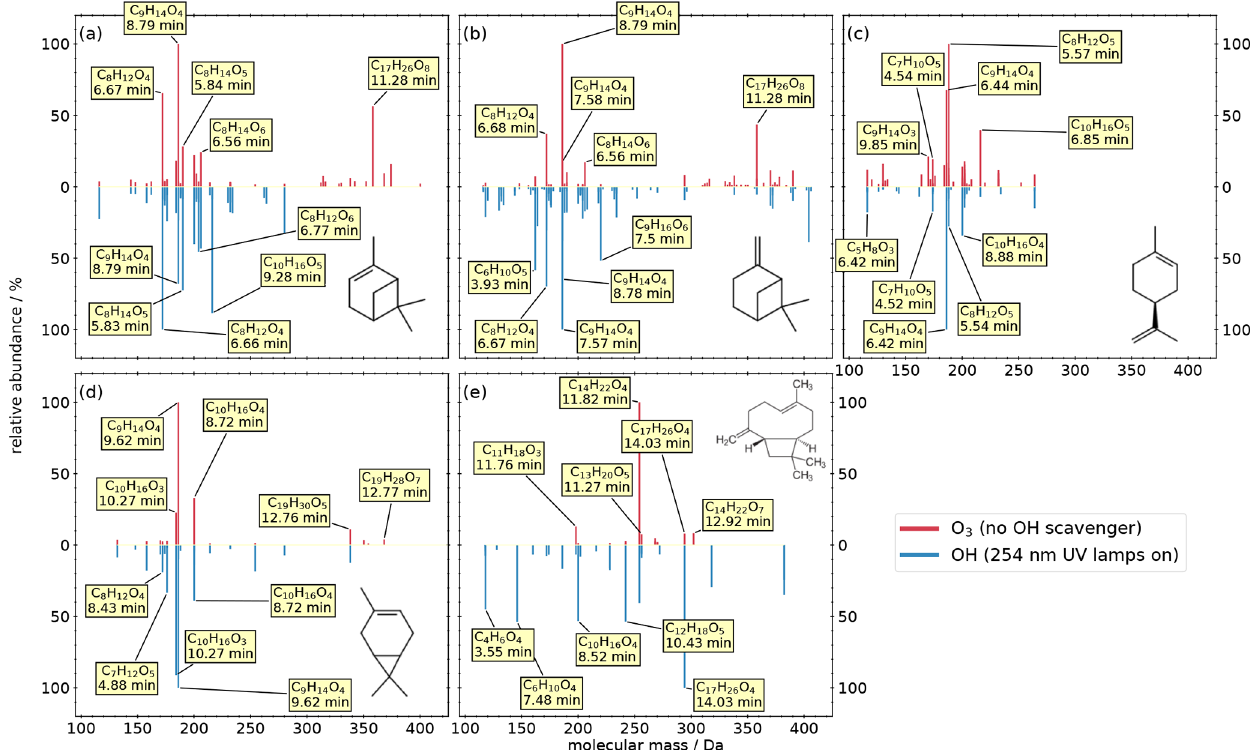
Figure 2. Mass spectra of the detected products from the OFR experiments of five biogenic precursors: (a) α -pinene, (b) β -pinene, (c) limonene, (d) 3-carene, (e) and trans- caryophyllene. The intensity is normalized to the highest signal of each chemical system. The most abundant compounds of each experiment are labeled with their predicted composition and the according retention